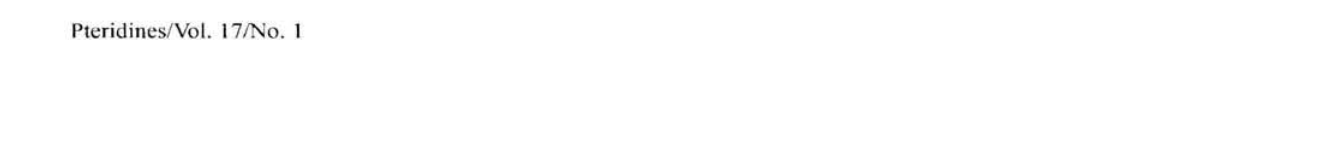
(Fig. 5). The amino acid sequences are 28-38% identi- cal and 36-52% similar within the common region.